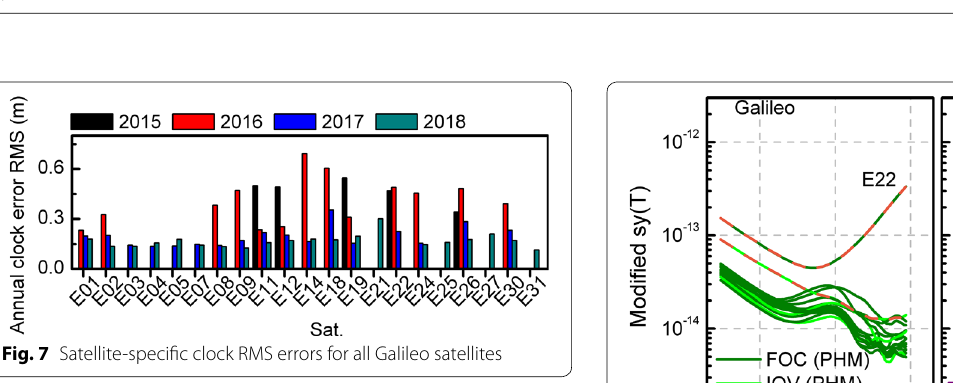
Fig. 6 Time series of Galileo FNAV ( top ) and GPS IIF LNAV ( bottom ) broadcast clock errors and frequency histogram ( right ). Mean and STDs for each year are indicated at the bottom in centimeters